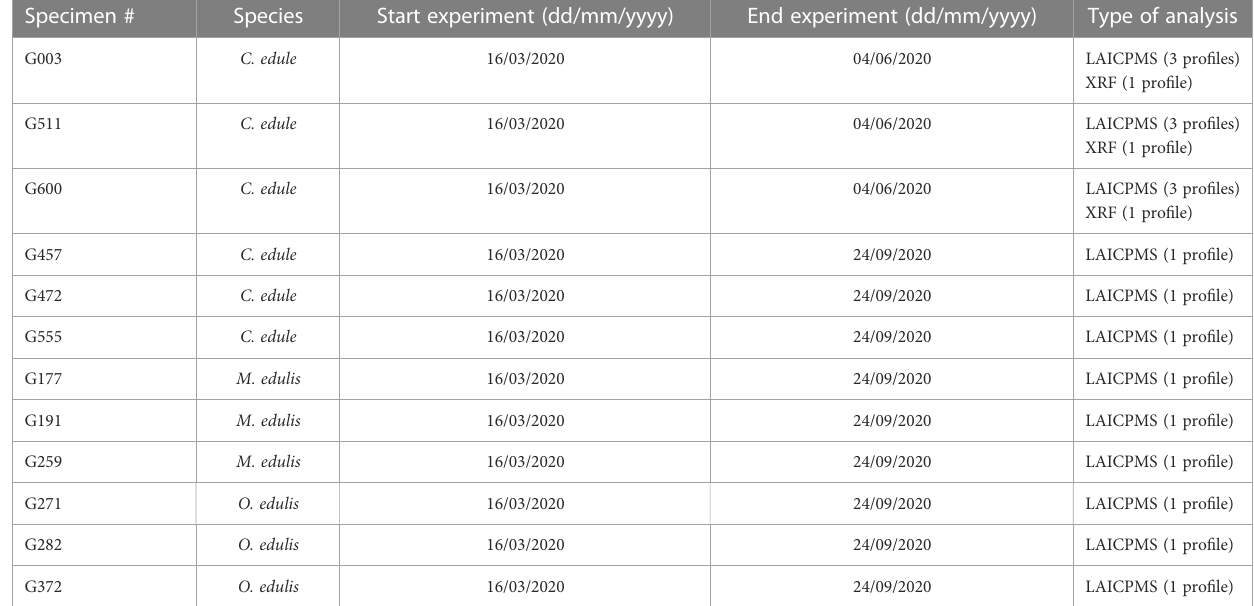
TABLE 2 Overview of specimens analysed in this study and the types of analyses carried out on their shells. Specimen